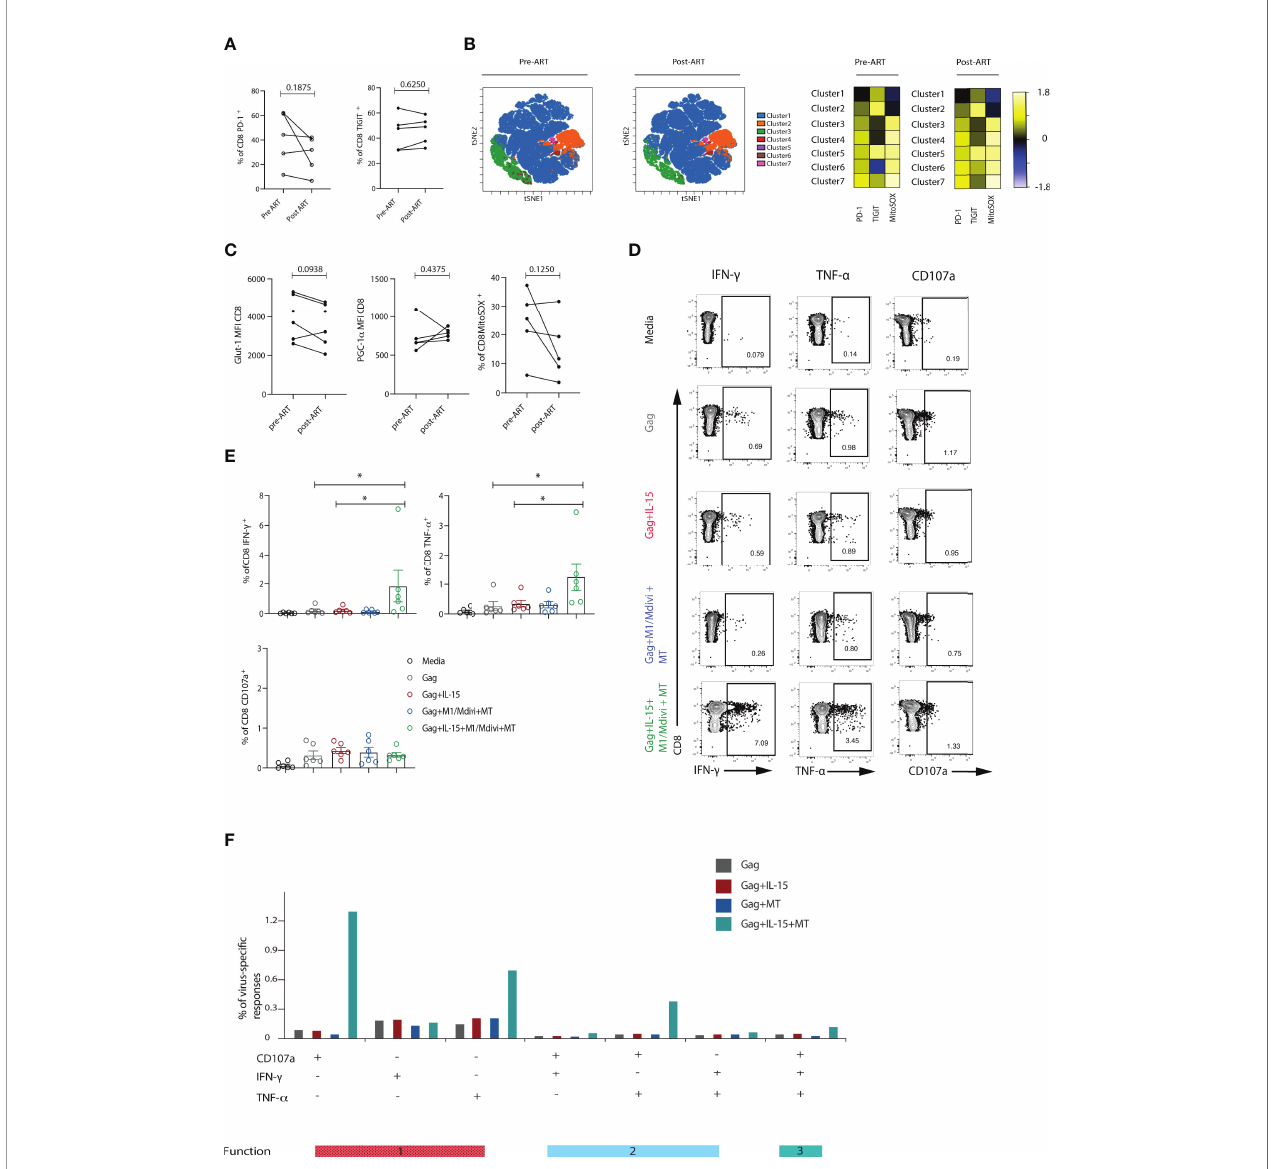
FIGURE 6 | Metabolic abnormalities persisted in ART-suppressed patients. (A) Longitudinal analysis of the frequency of PD-1 + or TIGIT + CD8 T cells from HIV-1 positive individuals before and after 12 months of ART suppression (n = 5). (B) viSNE map of FlowSOM clustering of CD8 T cells in longitudinal samples. Heatmap showing expression of TIGIT and PD-1 markers for each cluster; Representative fl ow plots and (C) Glut-1 expression (n = 6), PGC-1 a expression (n = 5) and percentage of MitoSOX + (n = 5) CD8 T cells from HIV-1 positive individuals before and after ART treatment. (D) Representative fl ow plots and (E) Summary data showing percentage of IFN- g , TNF- a and CD107a positive CD8 T cells after 6-hour stimulation with Gag peptides in the presence or absence of IL-15, and M1, mdivi and MitoTempo (MT) in n = 6 HIV-1 ART treated individuals. (F) SPICE analysis bar charts of IFN- g , TNF- a and CD107a responses in Gag-speci fi c CD8 T cells showing 1 function, 2 functions, or 3 functions of Gag-speci fi c CD8 T cells following treatment with different conditions. Wilcoxon matched-pairs signed rank test, *p <